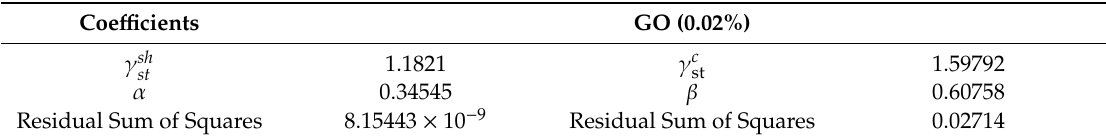
Table 9. Influential and exponential coefficients (concrete containing 0.02% GO nanosheets by weight of cement).